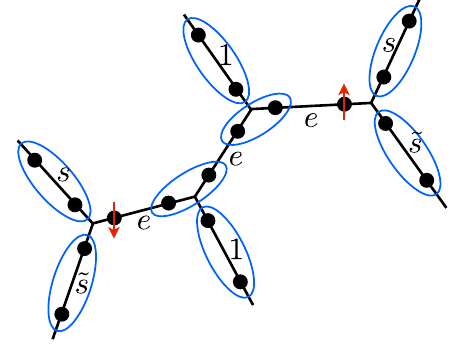
FIG. 6. Sample spin configuration in the decorated Walker- Wang model. Black dots represent spin 1 = 2 ’s, and blue ellipses represent spin singlets. The leftmost vertex has a counterclock- wise ð e; s; ~ s Þ ordering of labels and so prefers a down spin, whereas at the rightmost vertex, the counterclockwise label ordering is ð e; ~ s; s Þ and an up spin is preferred (red